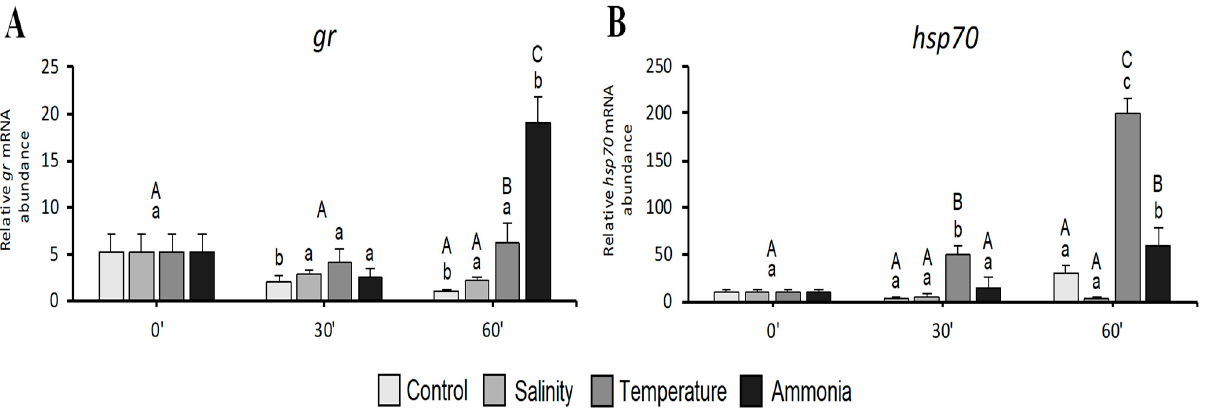
Figure 2. Relative mRNA levels of genes involved in stress response analysed in seabream juveniles: ( A ) gr and ( B ) hsp70 . Data are expressed as mean ± SD ( n = 15). Different letters denote statistically significant differences in time course analysis (lowercase) or within the same sampling point (uppercase) ( p < 0.05).